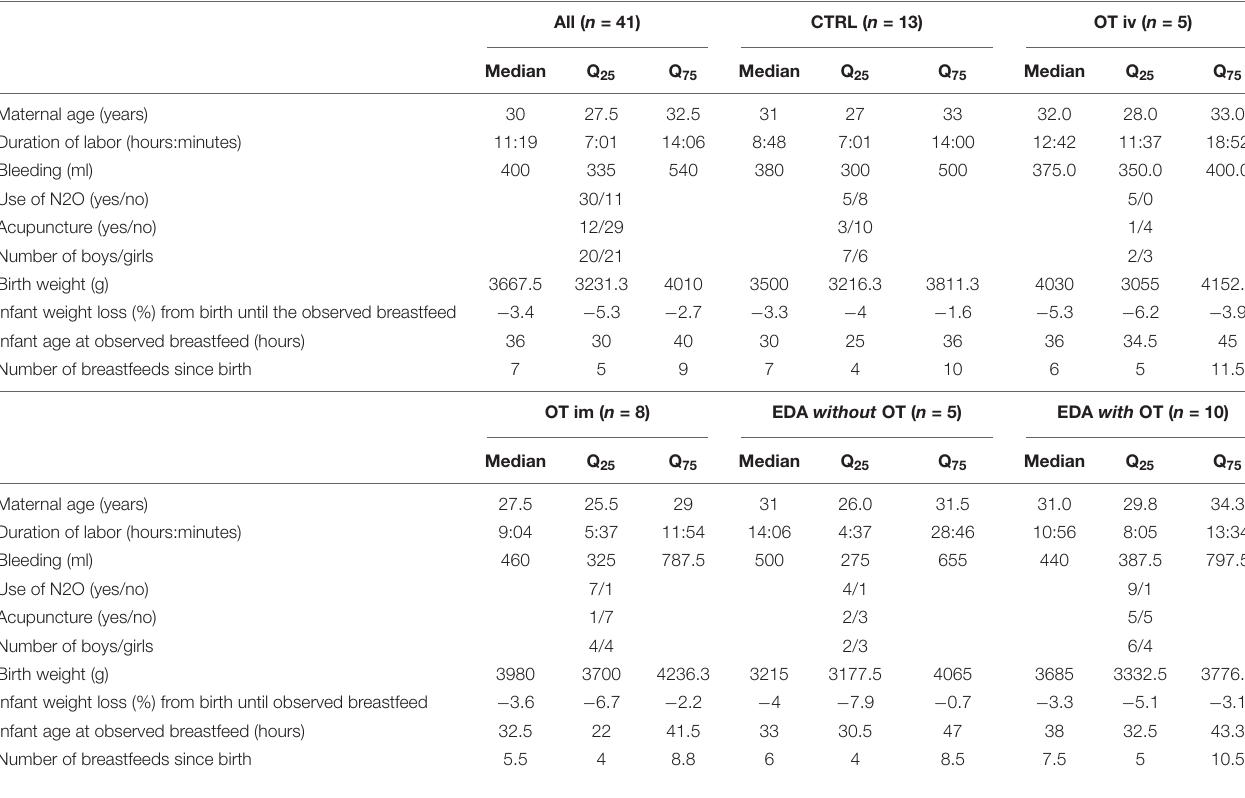
TABLE 3 | Clinical characteristics of all mothers and their infants and as a function of the medical interventions the mothers had received during childbirth (medians, interquartile ranges Q 25 –Q 75